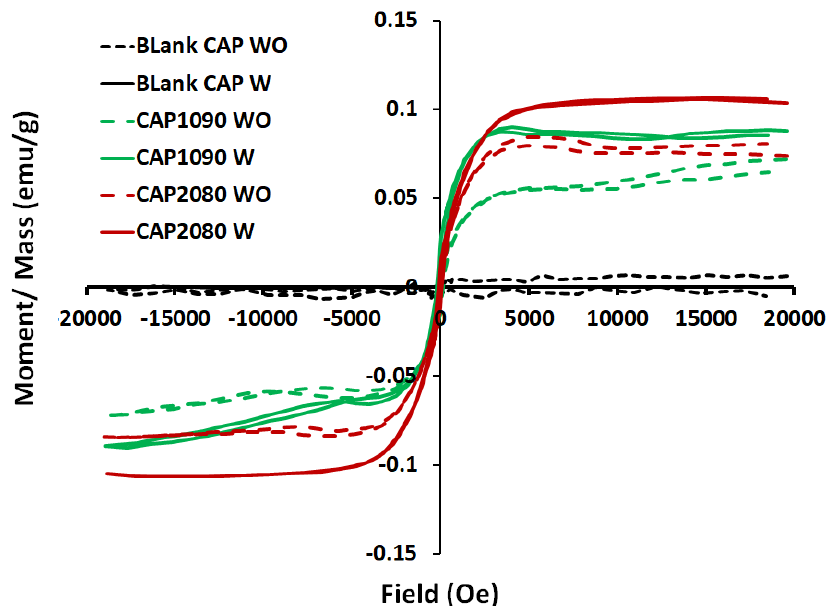
Figure 12. The M-H hysteresis loops of the blank cellulose acetate (CA) and the magnetic mixed CA matrix membranes without and with the addition of 0.1 wt.% of lithium chloride in the membrane dopes. Poly(methylmethacrylate) (0.8 wt.%) was used in the membrane dope of all the prepared membranes.